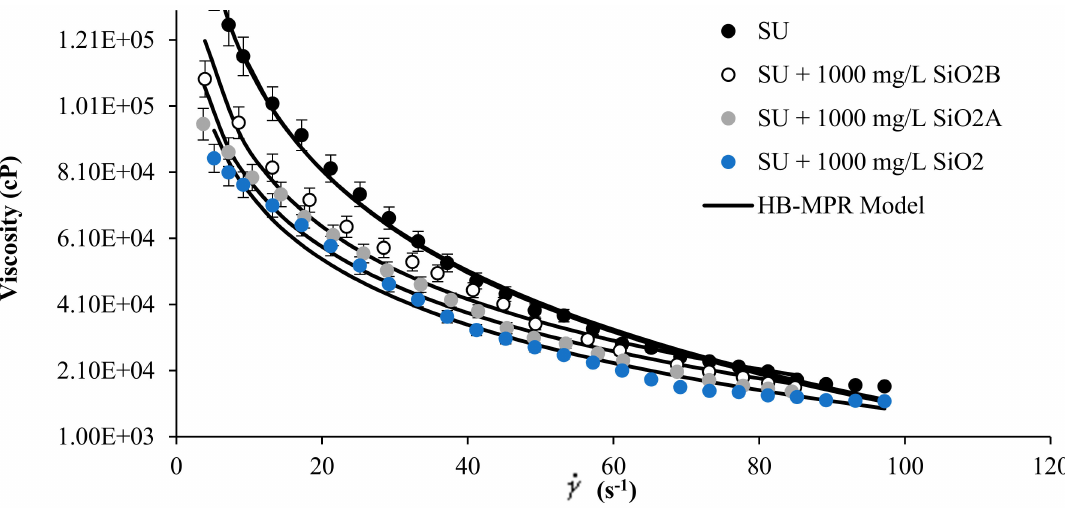
Figure 4. Viscosity of SU heavy oil in the presence of SiO 2 nanoparticles neutral (SiO 2 ), acid (SiO 2 A), and basic (SiO 2 B) at 1000 mg/L and 298 K and shear rate between 0 and 120 s − 1